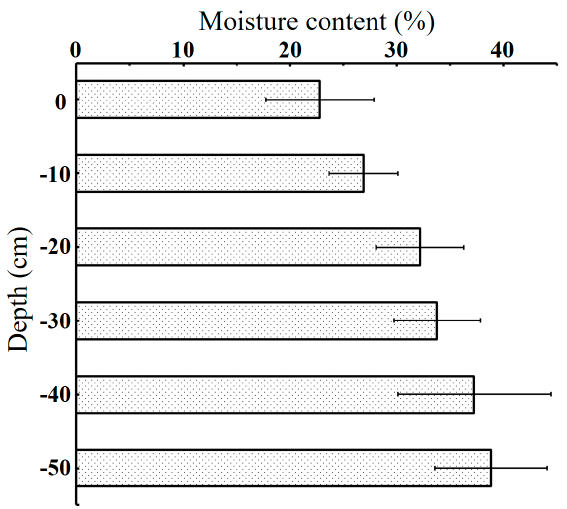
Figure 7. Variation of the soil moisture content with depth.